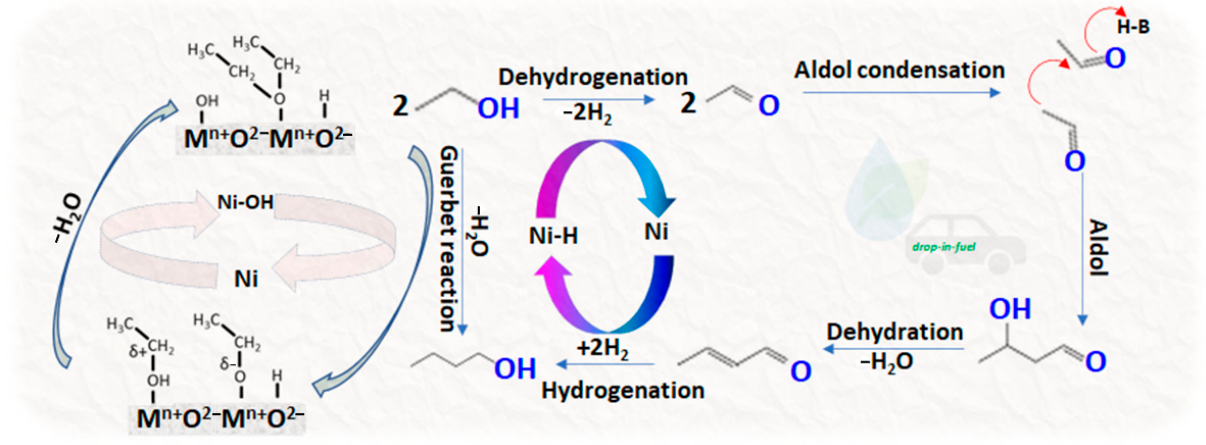
Figure 6. Mechanism of ethanol coupling with the proposed pathway of bimolecular dehydration to DEE. Based on [71,72].